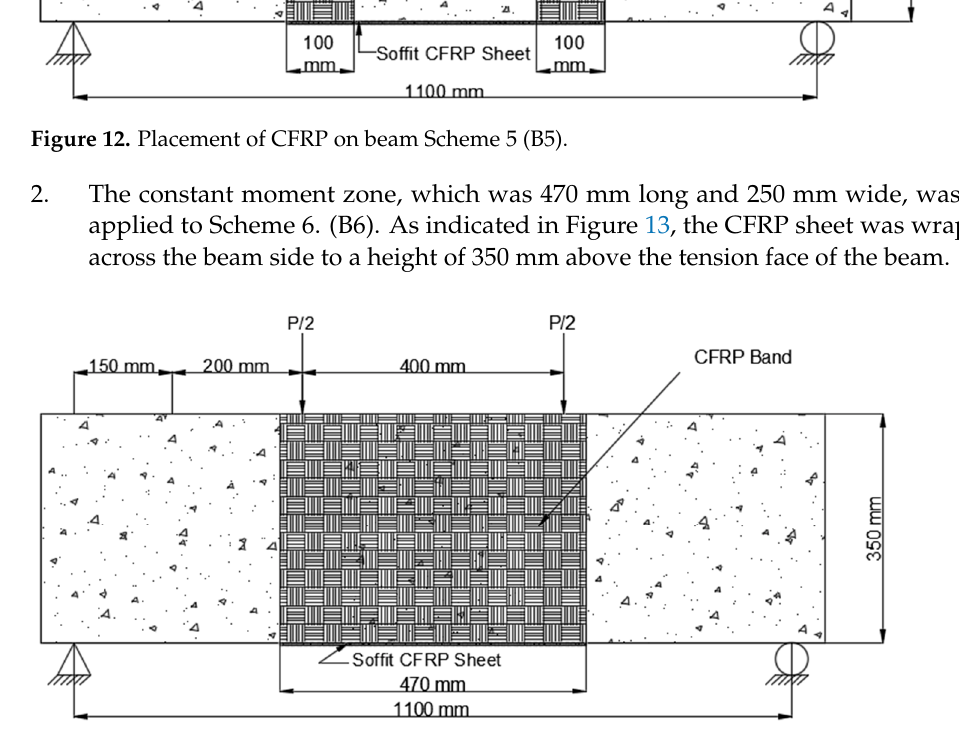
Figure 14. Placement of CFRP on beam Scheme 7 (B7). 4. Results and Discussions 4.1. Load-Deflection Behavior The crack formation with the application of load is shown in Figure 15 and the load- deflection behavior of the beam is shown in Figures 16 and 17. A dial gauge was posi- tioned at the mid-span of the test beam to acquire current data, and a hydraulic system was used to provide load. The mid-span deflection data for a 20 mm deflection was rec- orded. The fundamental reason for this is that none of the specimens failed in attaining that value. All modified beams were inspected under a Universal Testing Machine until failure occurred after 5 days of applying the CFRP sheets. The research was conducted using the same identical configuration as the control beam section testing and the results are identical with the prior studies [64–66].